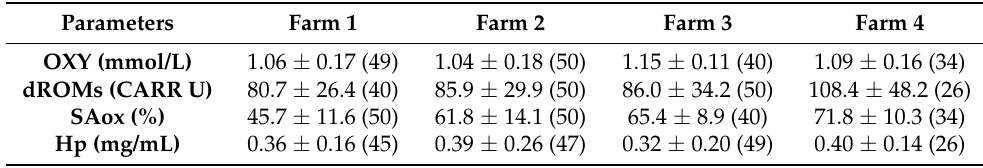
Table 5. Values of biomarkers of oxidative stress measured for the examined farms. Parameters